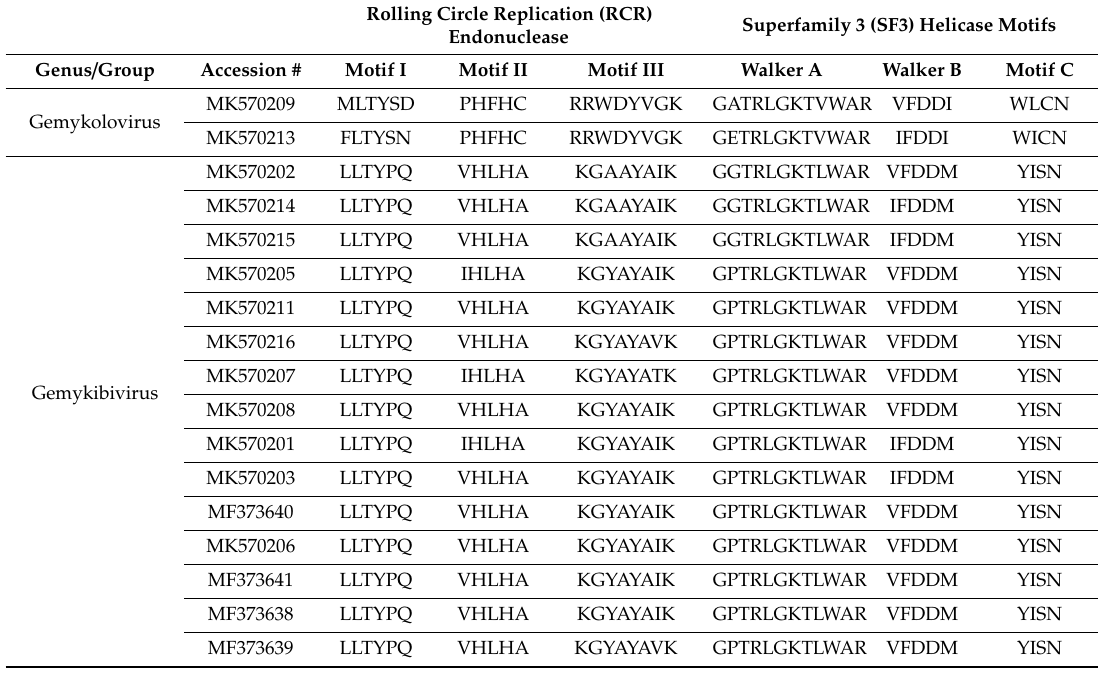
Table 1. Summary of the rolling circle replication (RCR) endonuclease motifs (Motif I, II, II) and superfamily 3 (SF3) helicase motifs (Walker A, Walker B, and Motif C) encoded genomoviruses, unclassified CRESS DNA viruses and Rep-encoding circular molecules identified in this